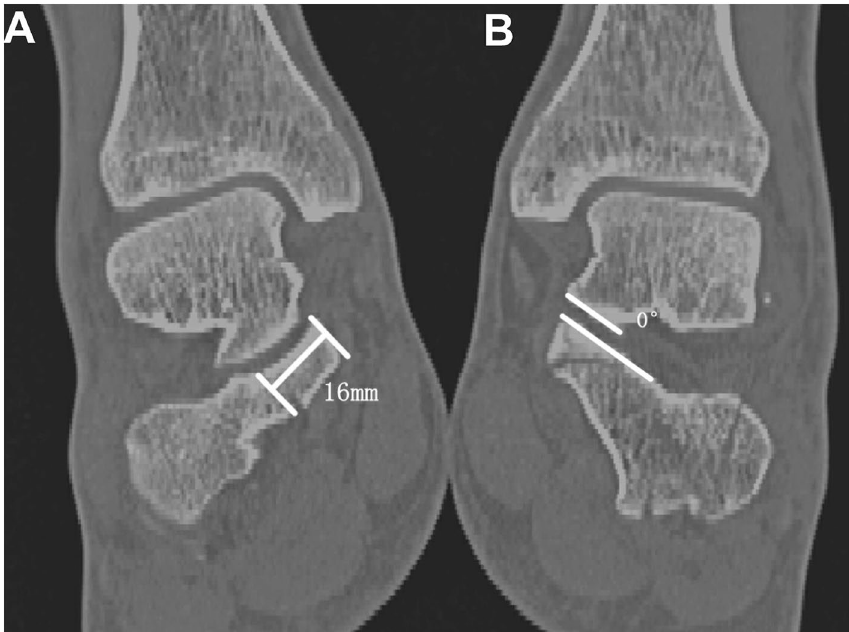
Figure 1. The method used for 2-D CT mapping of sustentacular fracture. ( A ) Coronal CT image showing the sustentacular fracture. ( B ) Assessment of angulation in the